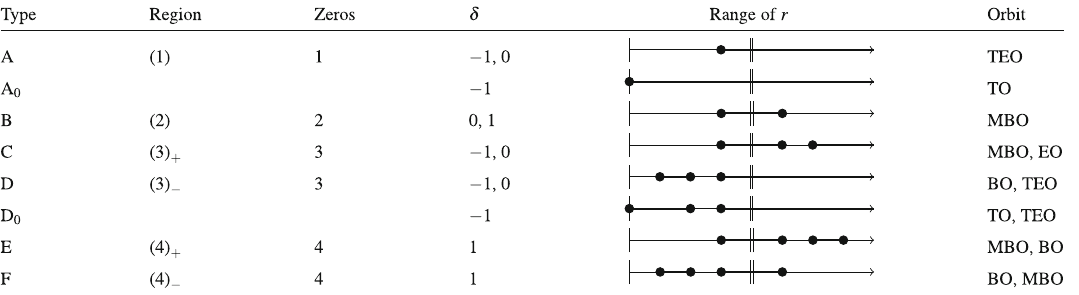
singularity, which can only be reached by particles of imaginary mass and K = 0, resulting in orbits of type A 0 and D 0 . The column δ dis- tinguishes between particles with imaginary/positive mass ( − 1/1) and light